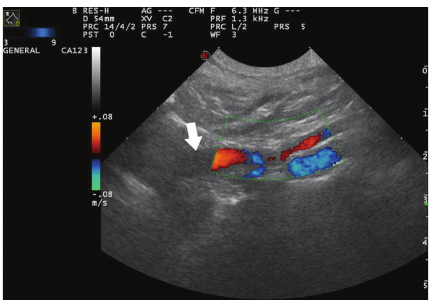
Figure 4: Recheck abdominal ultrasound at the level of the aortic bifurcation. The cranial portion of the dog is to the left of the image. The aorta is anechoic (arrow), and Color-flow Doppler application indicates blood flow within the aorta and external iliac